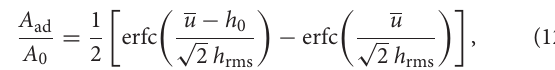
p ad / u u / h 0 σ 0 vs. = e e e